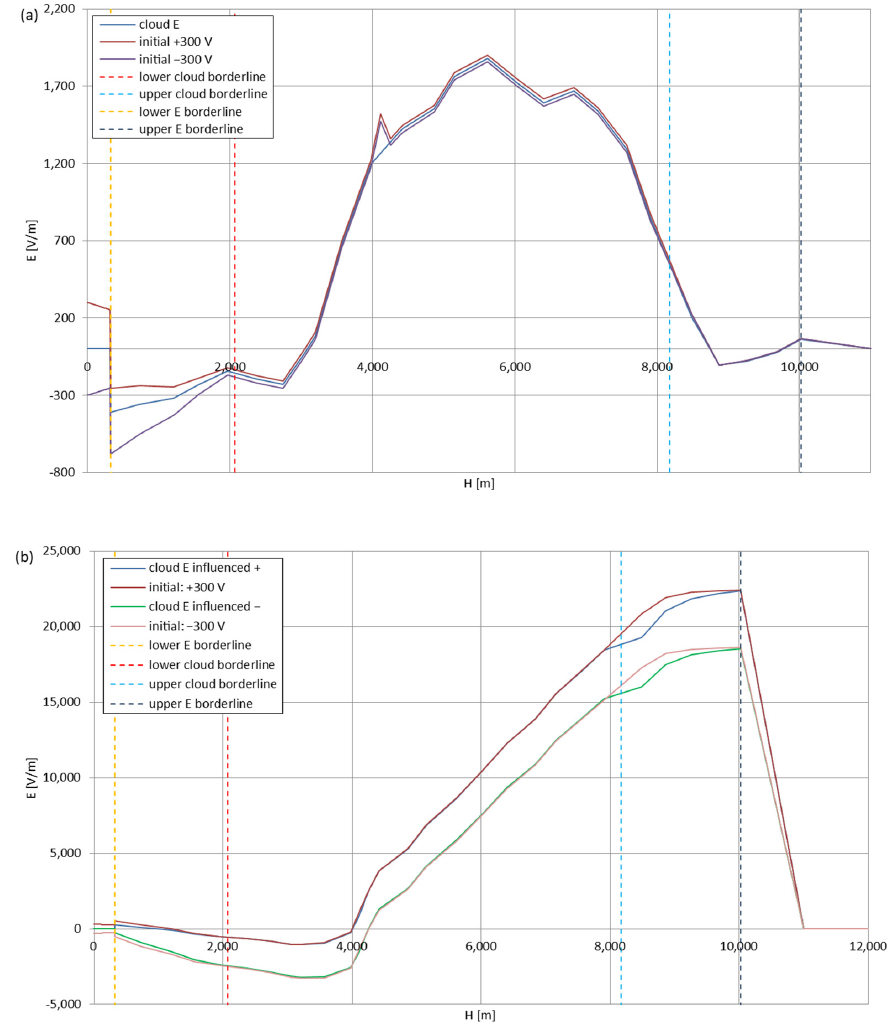
Figure 11. Maximum electric field strengths around the wire antenna passing through Nimbostratus cloud of mixed charge structure, Tashkent data: ( a ) ‘static’ case and ( b ) ‘dynamic’ case.